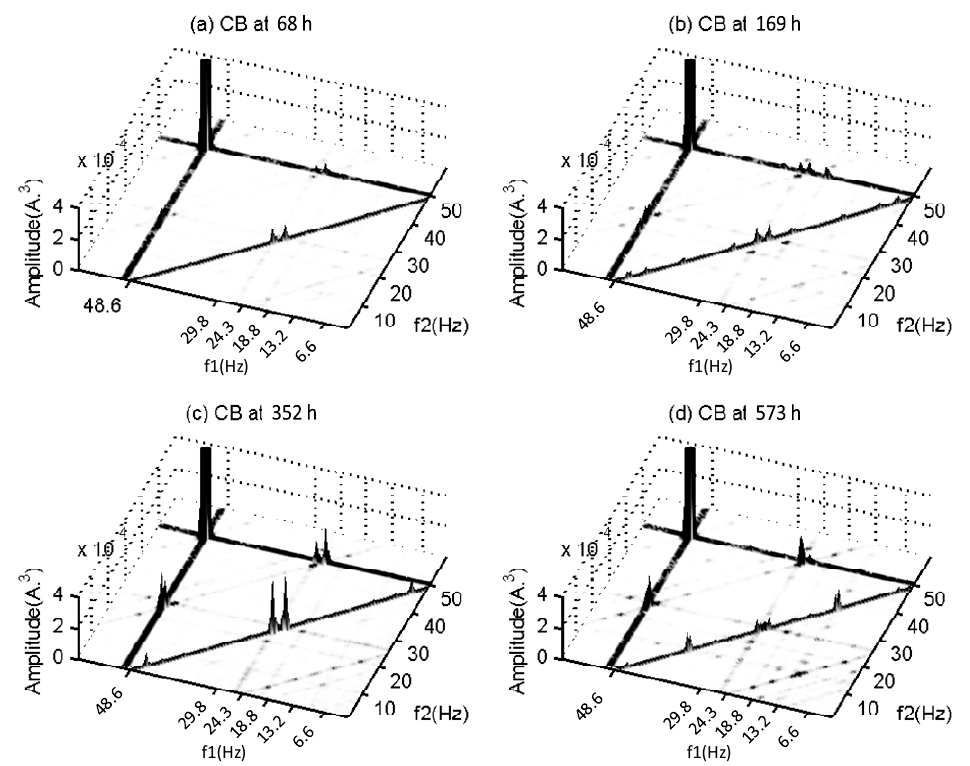
Figure 10. CB amplitudes for gearbox deterioration at successive time instants.